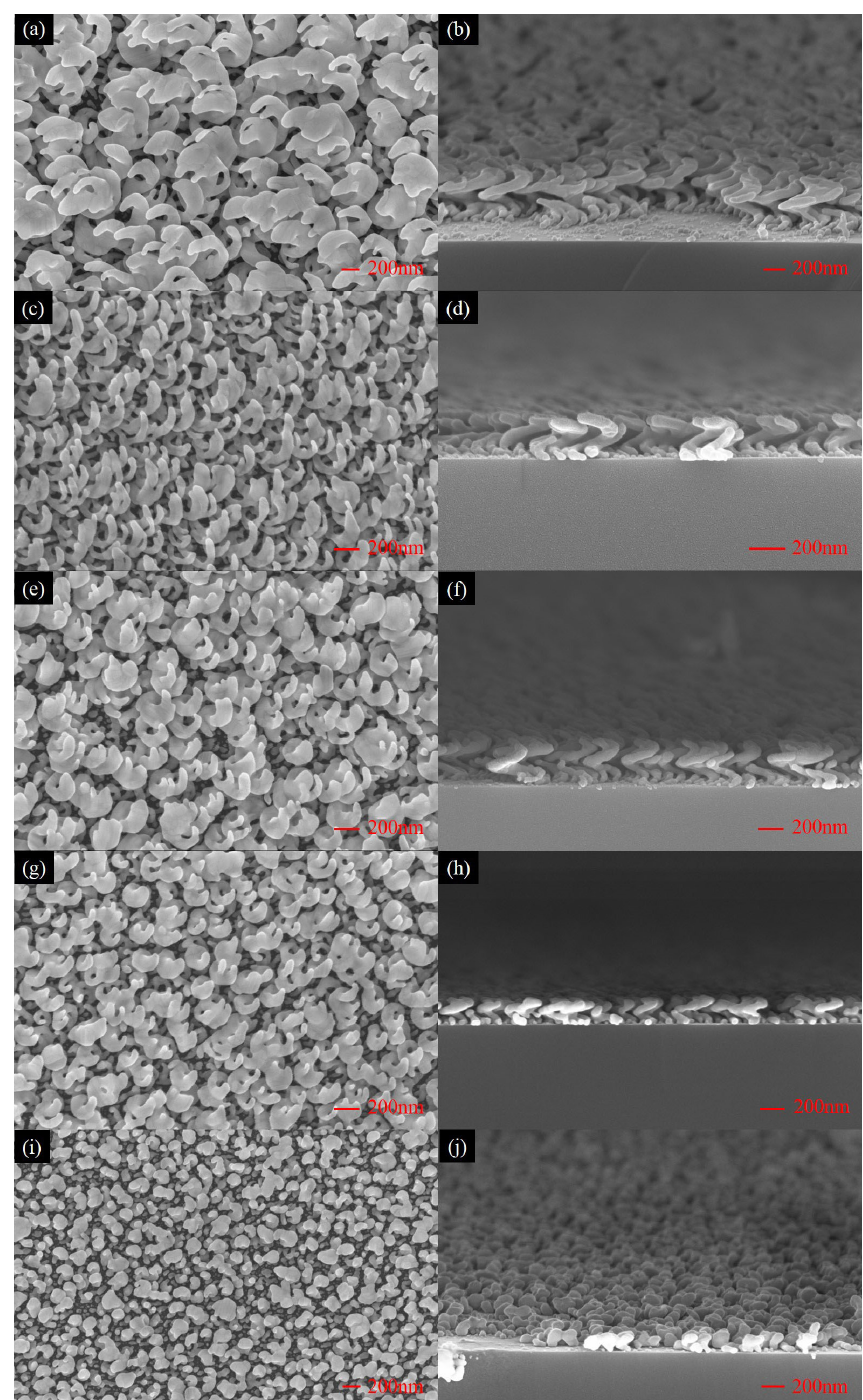
Figure 2. Top ‐ view and cross ‐ section SEM images of Ag nanohelix arrays deposited at spin rates of ( a , b ) 0.012 rpm, ( c , d ) 0.018 rpm, ( e , f ) 0.023 rpm, ( g , h ) 0.029 rpm and ( i , j ) 0.035